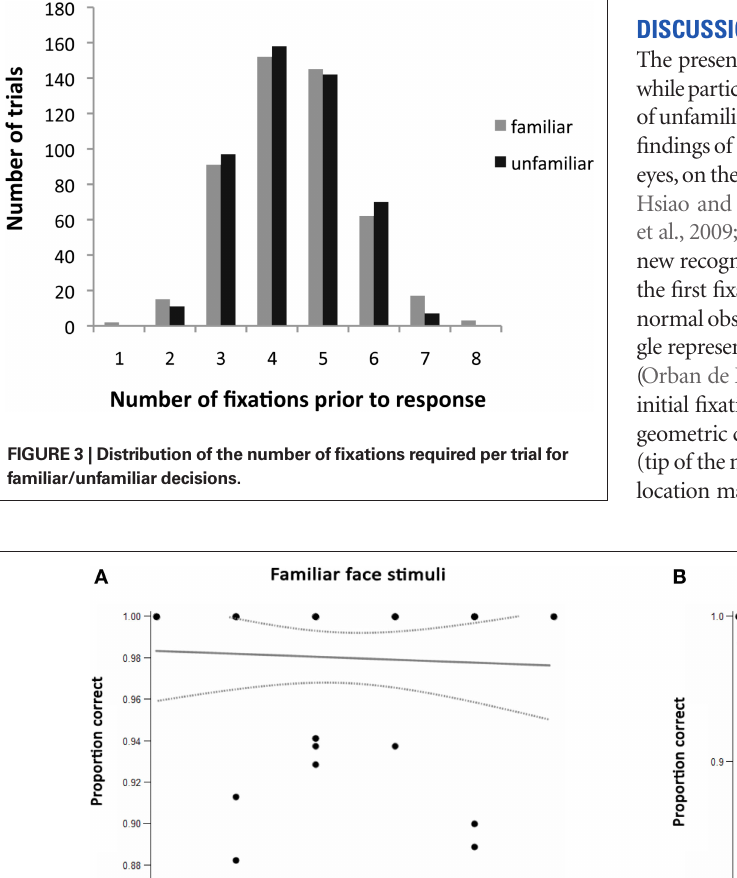
Figure 4 | Accuracy as a function of number of fixations prior to recognition, separately for (A) familiar and (B) unfamiliar face stimuli. Dots represent individual participants’ average accuracy for a given number of